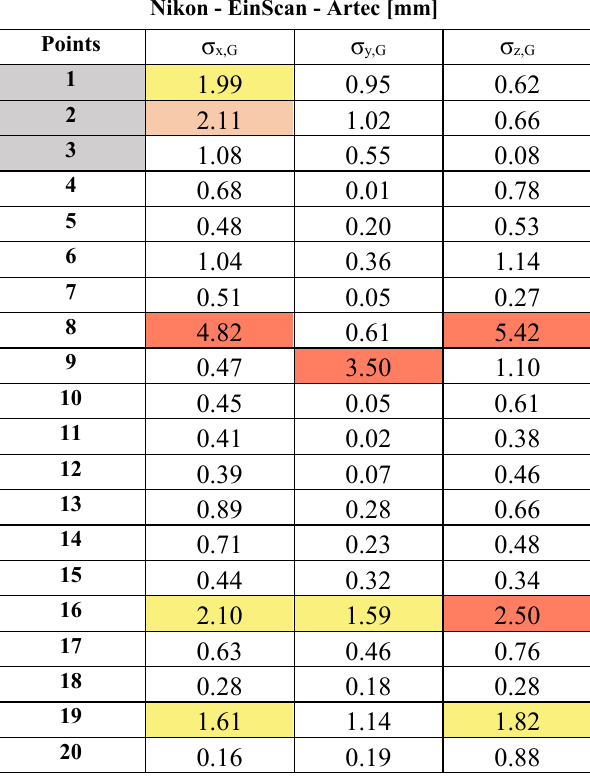
Table 13. Global standard deviation calculation